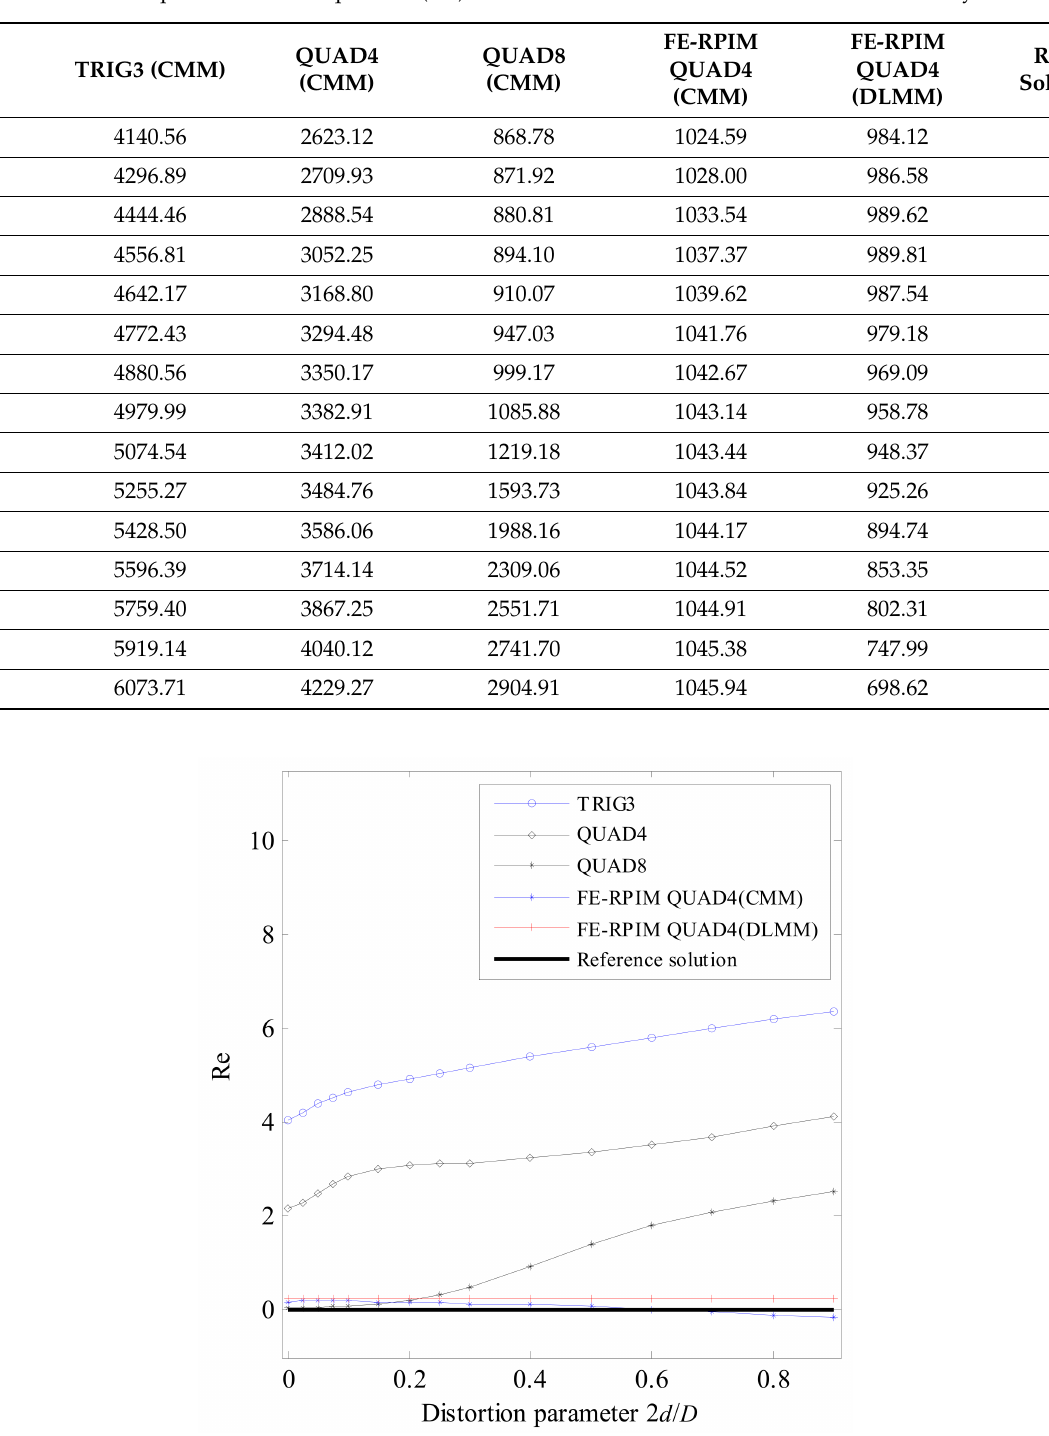
Table 3. Computed natural frequencies (Hz) of the first mode for the mesh distortion sensitivity test.